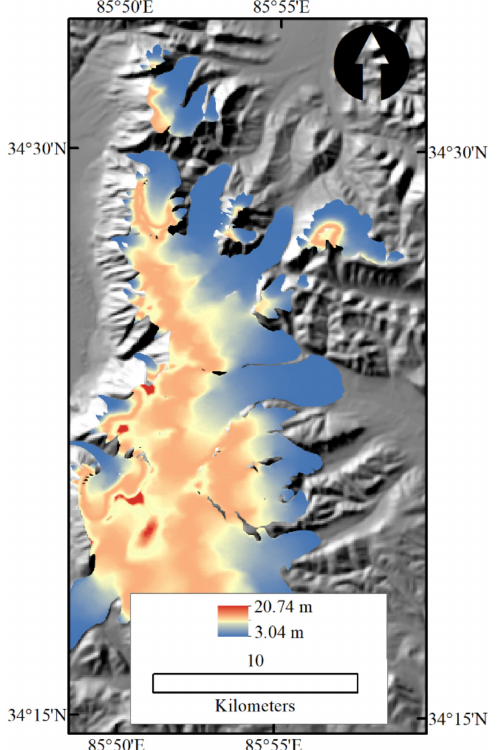
Figure A6. The penetration depth between SRTM X DEM and SRTM C